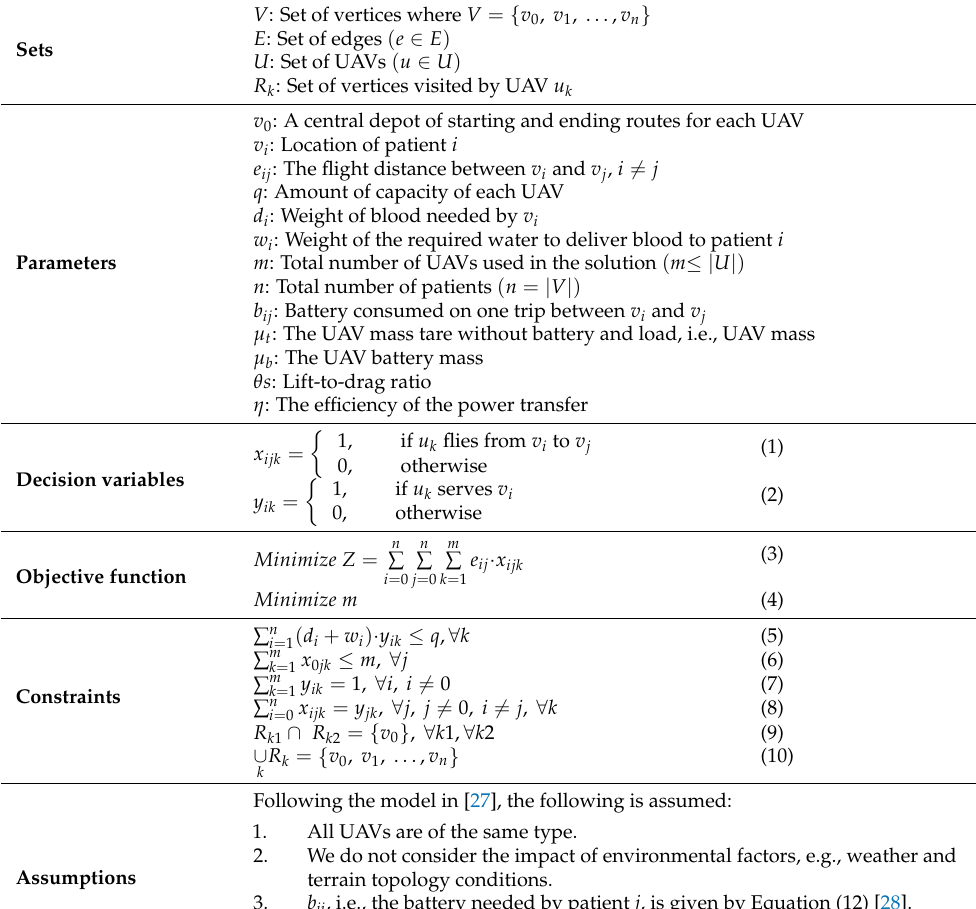
Figure 2. An example of the locations of the central depot and the patients. Table 1. Formulation of the UCVRP.